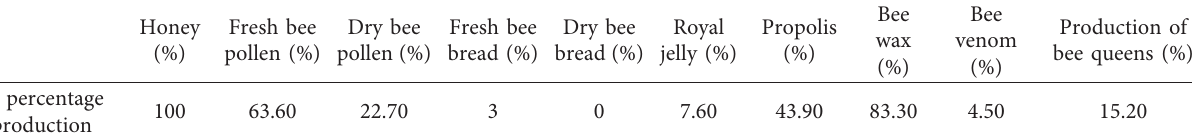
Table 2: Types and percentages of bee hive production.